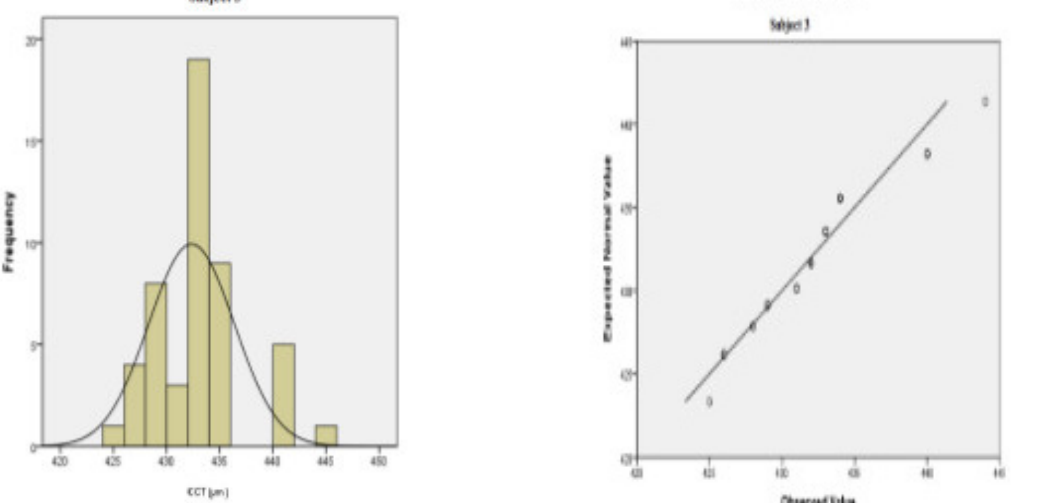
Figure 5: Histograms and normal probability plots for the CCT sample of subject 3. The sample for CCT was not normally distributed (the p -values for the K-S, Lilliefors and S-W tests were <